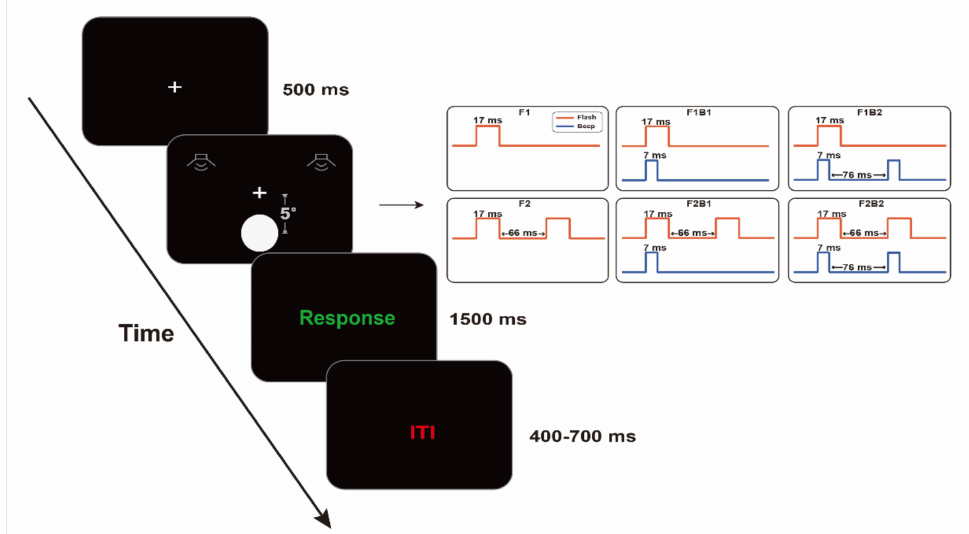
Figure 1. A schematic representation of experimental stimuli. There are six conditions, F1, F1B1, F1B2, F2, F2B1 and F2B2. F1 indicates the condition of presenting a flash, F1B1 indicates the condition in which a flash and a beep, F1B2 indicates the condition in which a flash and two beeps, F2 indicates that two flashes are present, F2B2 indicates that two flashes and two beeps at the same time, and F2B1 indicates the condition in which two flashes and a beep. The flash rendering time was 17 ms, and there was an interval of 66 ms between the two flashes. The beep rendering time was 7 ms, and there was an interval of 76 ms between the two beeps. At the beginning of each trial, the black screen showed a white “+” for 500 ms in the center, and the response screen showed 1500 ms, followed by 400–700 ms intertrial intervals (ITI). The red line indicates a flash, and the blue line indicates a